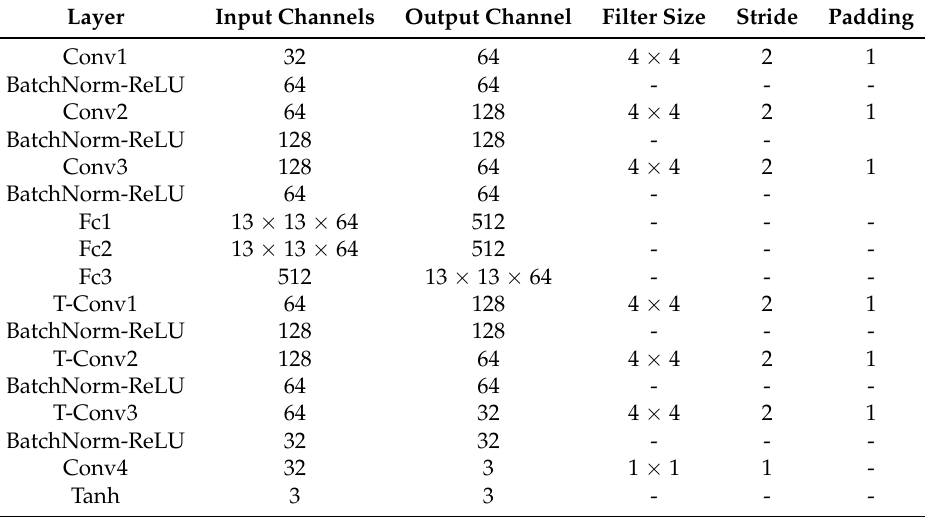
Table 1. The detail of each layer in the Structure Attention Network.